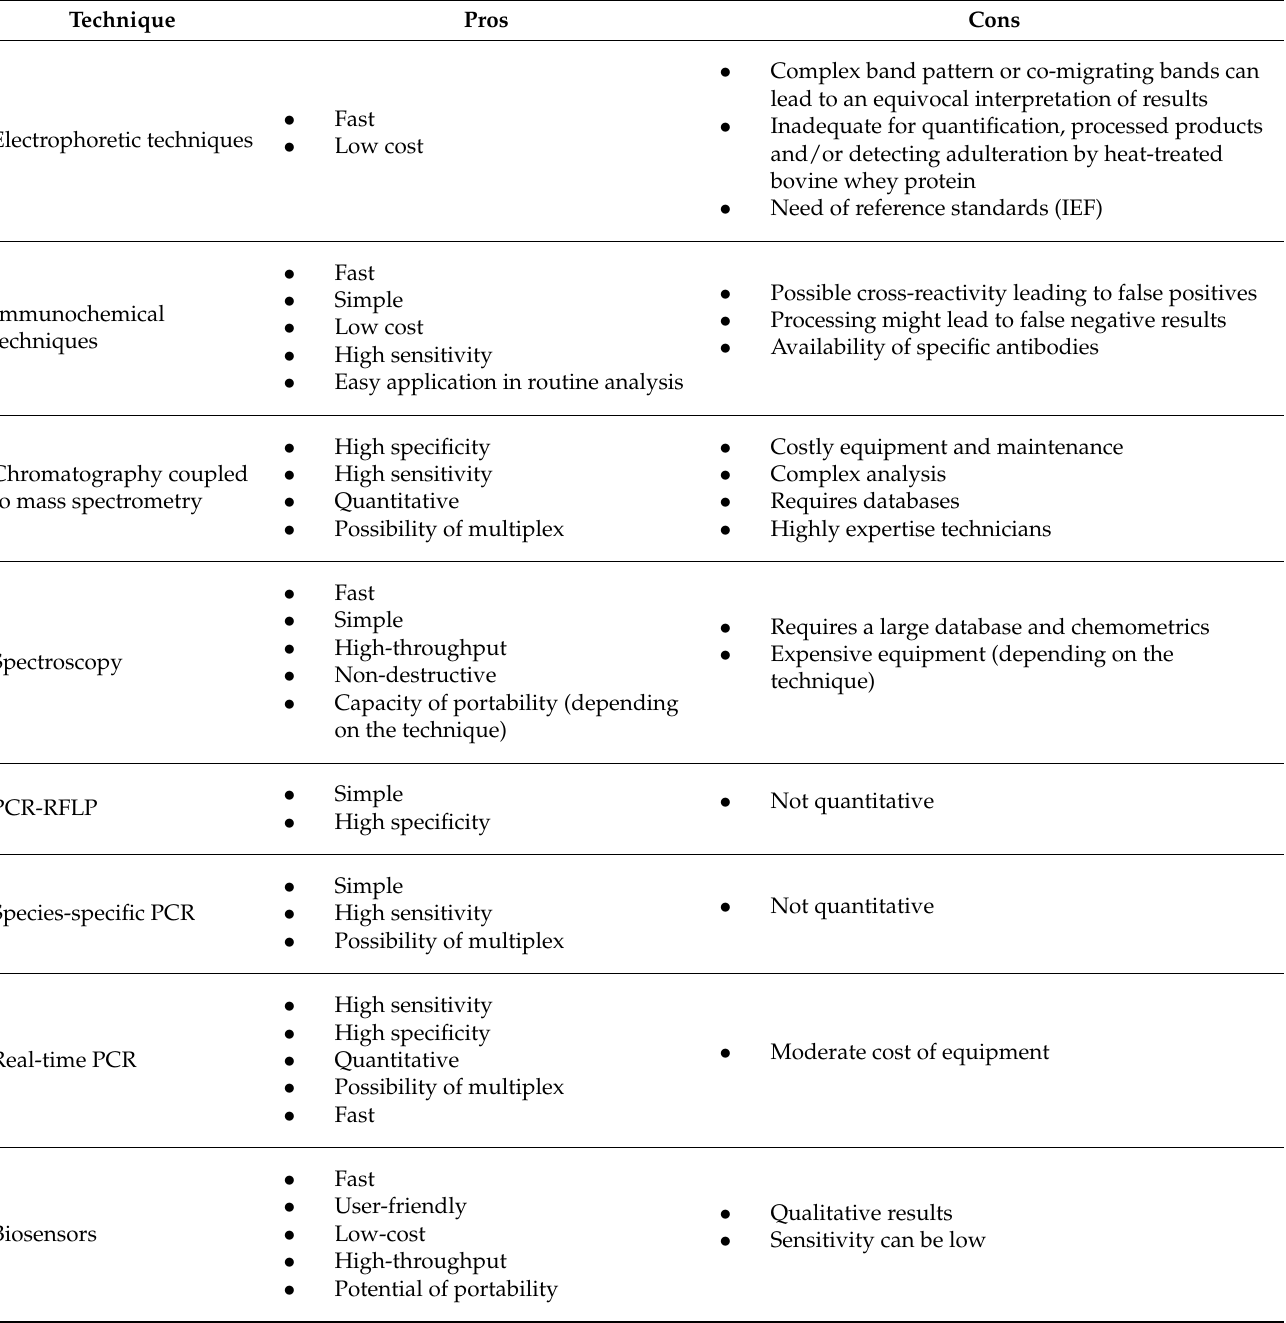
Table 4. Summary of pros and cons of the main techniques applied for species identification in dairy products. Pros